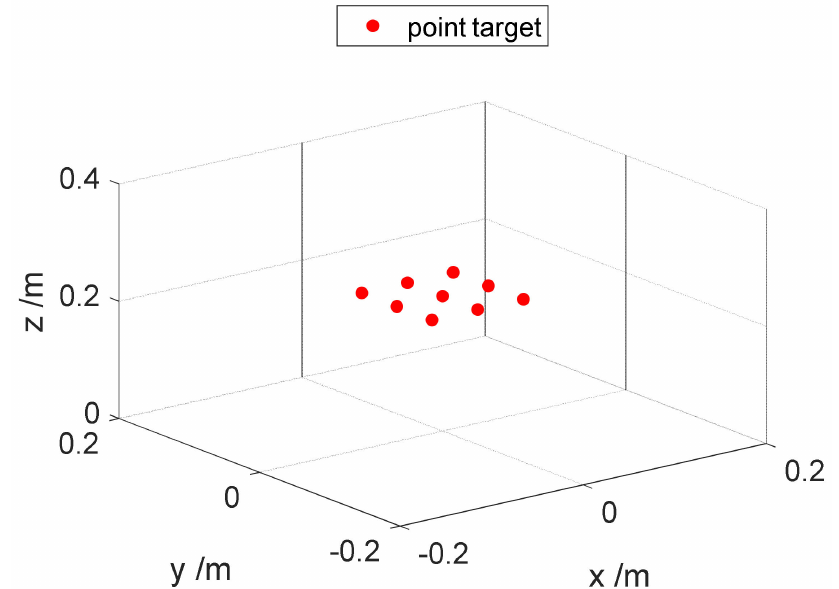
Figure 4. The geometric model of the point target.